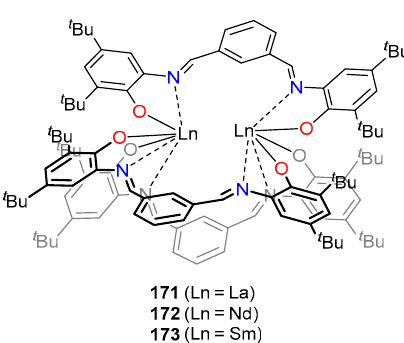
Figure 30. Dinuclear Ln-complexes bearing a tetradentate Schiff-base ligand [90].